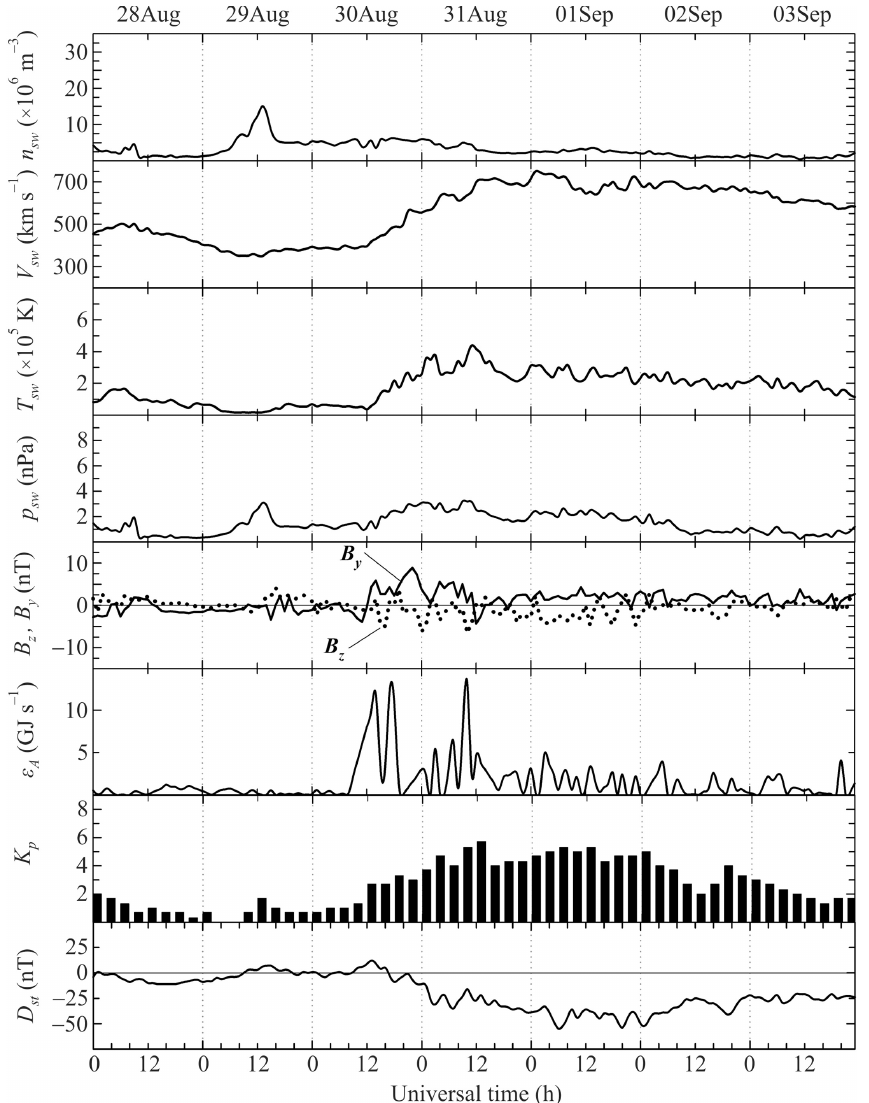
Figure 2. Universal time dependencies of the solar wind parameters. Proton number density n sw , temperature T sw , plasma flow speed V sw (retrieved from https://omniweb.gsfc.nasa.gov/form/dx1.html, last access: 18 June 2021), calculated dynamic pressure p sw , components B z and B y of the interplanetary magnetic fields (retrieved from https://omniweb.gsfc.nasa.gov/form/dx1.html, last access: 18 June 2021), and calculated energy input per unit time, ε A , from the solar wind into the Earth’s magnetosphere. K p and D st index (retrieved from https: //omniweb.gsfc.nasa.gov/form/dx1.html, last access: 18 June 2021) for 28 August–3 September 2019 period. Dates are shown along the upper abscissa